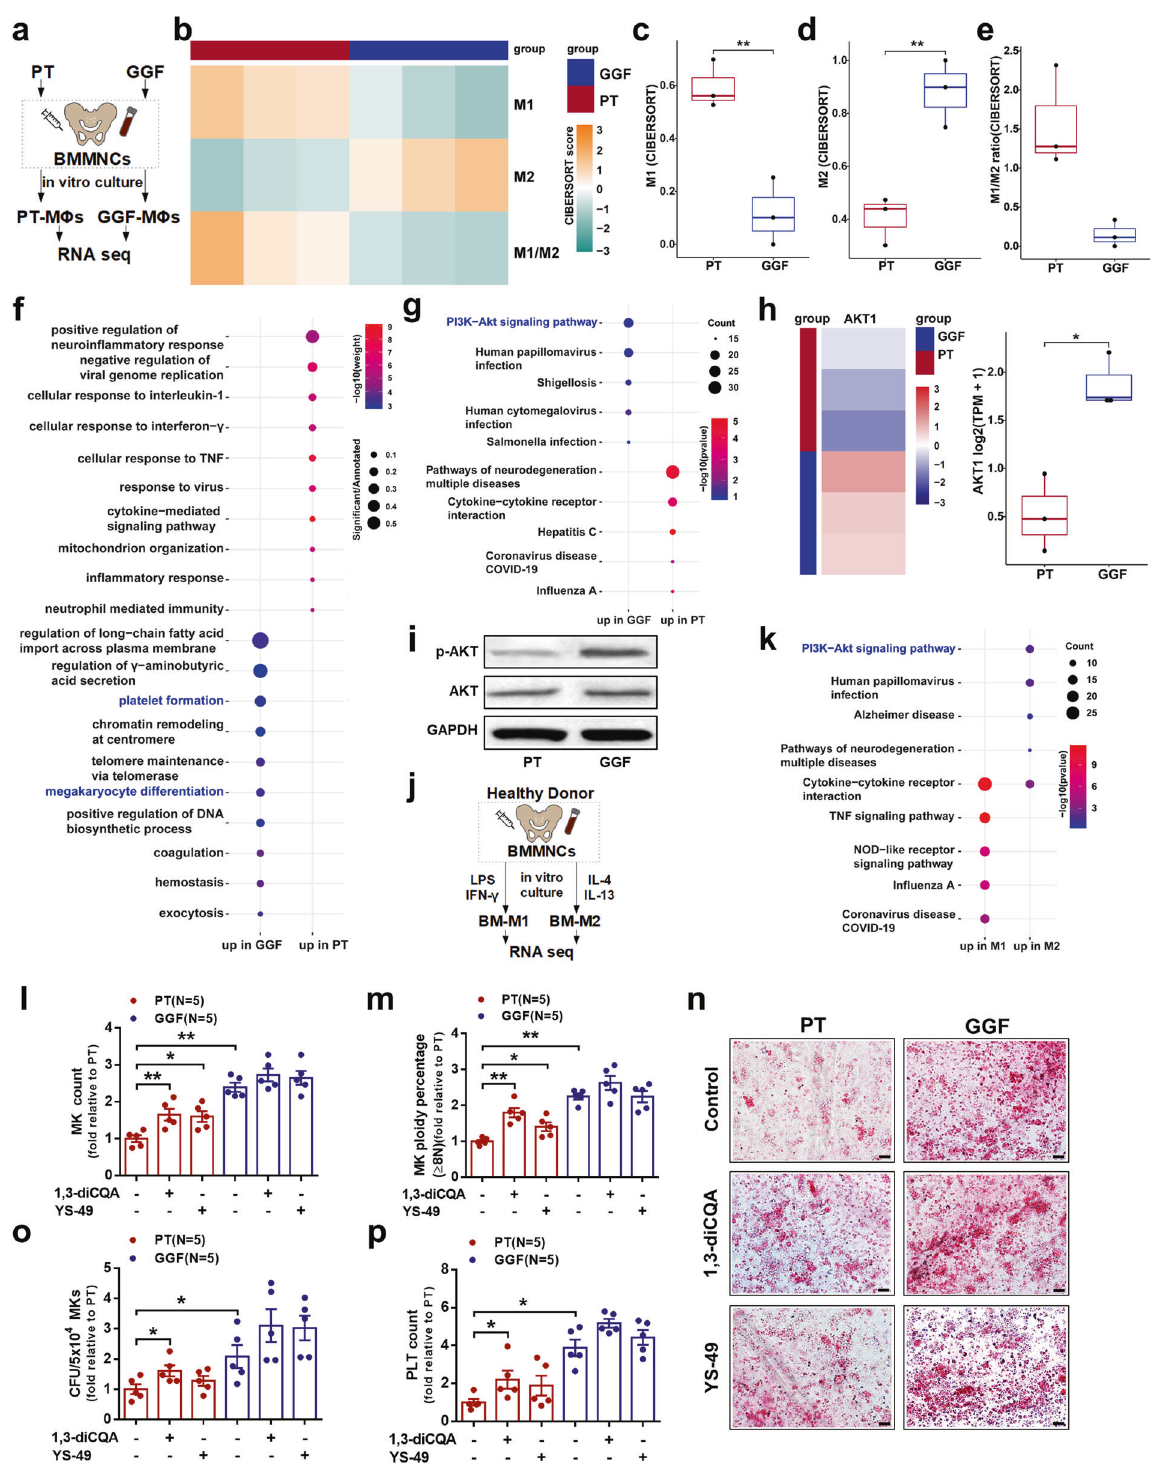
megakaryopoiesis-supporting capacity compared with BM-M1, as indicated by increases in MK count (Fig. 4a; 1.6 ± 0.14-fold vs. 0.04 ± 0.06-fold, P = 0.0002), percentage of high-ploidy MKs (Fig. 4b and Supplementary Fig. S2i; 1.82 ± 0.15-fold vs. 0.52 ± 0.06-fold, P = 0.0002), number of CFU-MKs (Fig. 4d, e; 1.45 ± 0.11-fold vs. 0.56 ± 0.07-fold, P = 0.002) and platelet count (Fig. 4c; 1.52 ± 0.11-fold vs. 0.46 ± 0.06-fold, P =